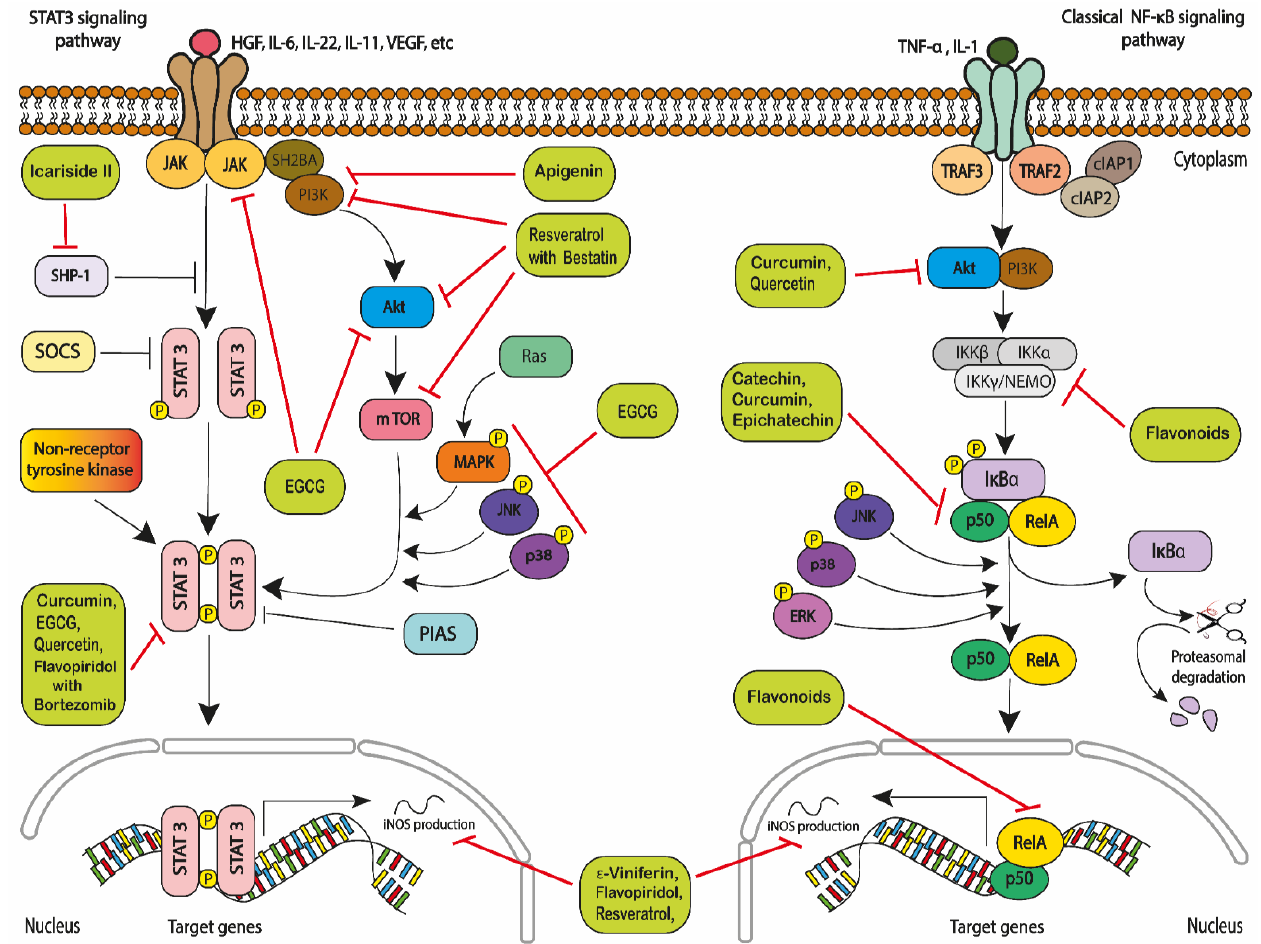
Figure 3. The classical NF- κ B ( Right ) and STAT3 ( left ) activation pathways. The NF- κ B pathway is initiated by numerous stimuli including TNF α and IL1 and is mediated by the I κ B kinase (IKK) complex. This results in the phosphorylation of IkB α and leads to degradation by the proteasome. This releases RelA/p50 complex to be translocated into the nucleus and binds to DNA to induce the expression of specific genes. STAT3 is activated by the Janus kinase (JAK)/signal transducer, non-receptor tyrosine kinase signalling pathways and Ras/mitogen-activated protein kinase (MAPK). Suppressor of cytokine signalling (SOCS) and protein inhibitor of activated STAT3 (PIAS3) can negatively regulate the activity status of STAT3. The activated form of STAT3 translocate into the nucleus and binds to the DNA of specific genes.